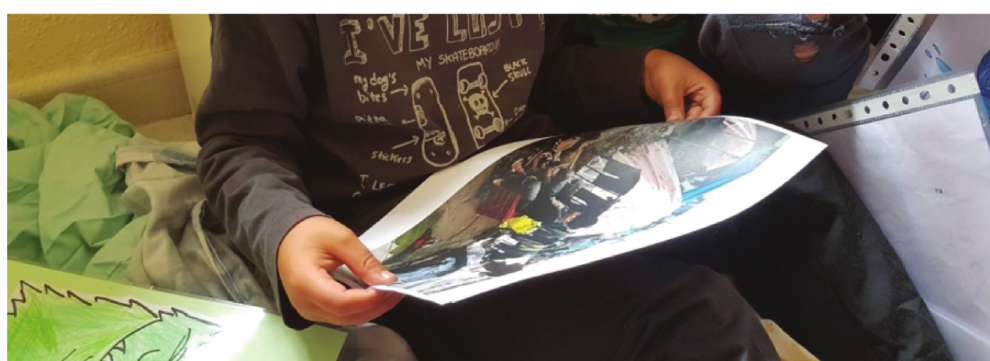
Figure 5: A student observes one of the images showing a refugee camp (Photograph: Author,